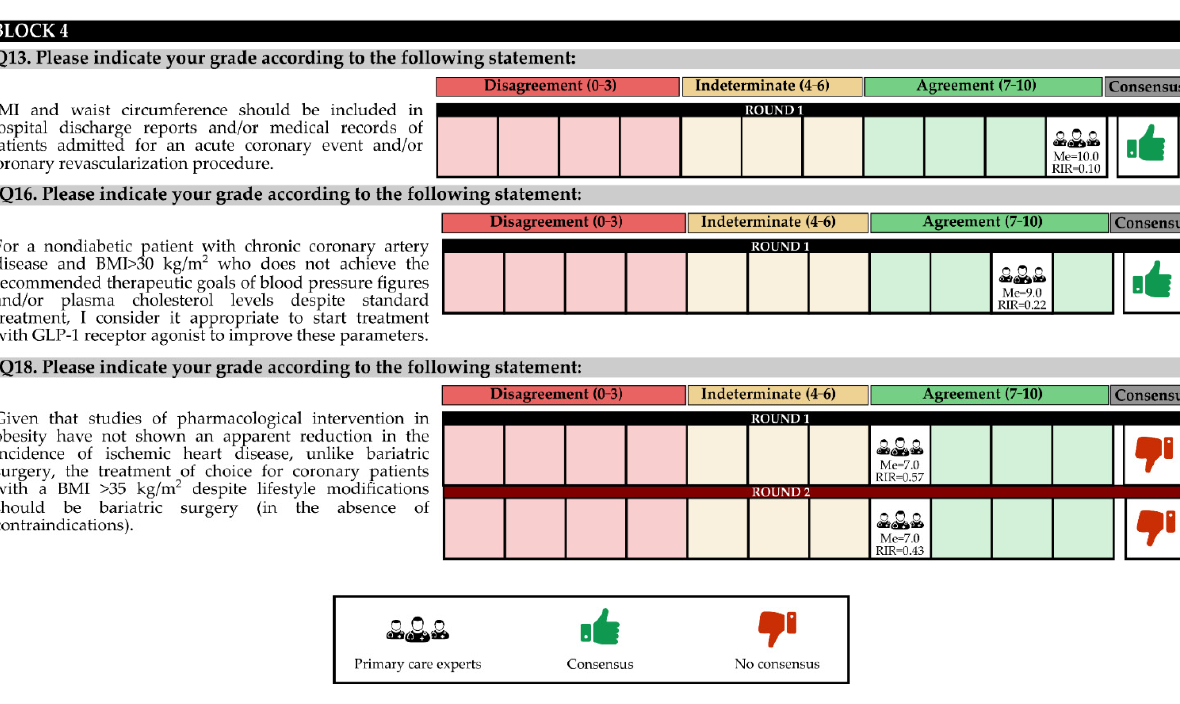
Figure 4. Discrete quantitative response questions of Block 3 under the Likert scale. IQR: Interquartile range; Me: Median. Table 1. Response-ordering questions. CV: Coefficient of variation.